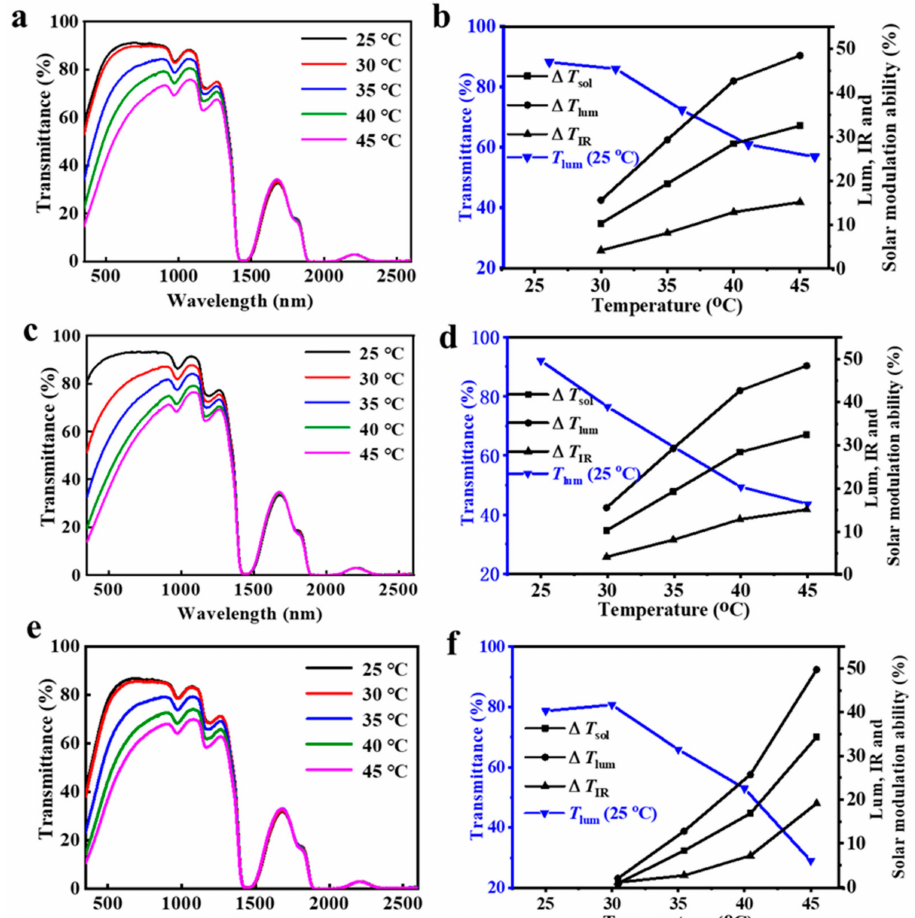
Figure 6. UV-vis near-IR spectra of ( a ) Composite 1, ( c ) Composite 2, ( e ) Composite 3 at di ff erent temperaturesfrom15to45 ◦ C;changesof T lum , ∆ T sol , ∆ T IR , and ∆ T lum of( b )Composite1, ( d )Composite 2, and ( f ) Composite